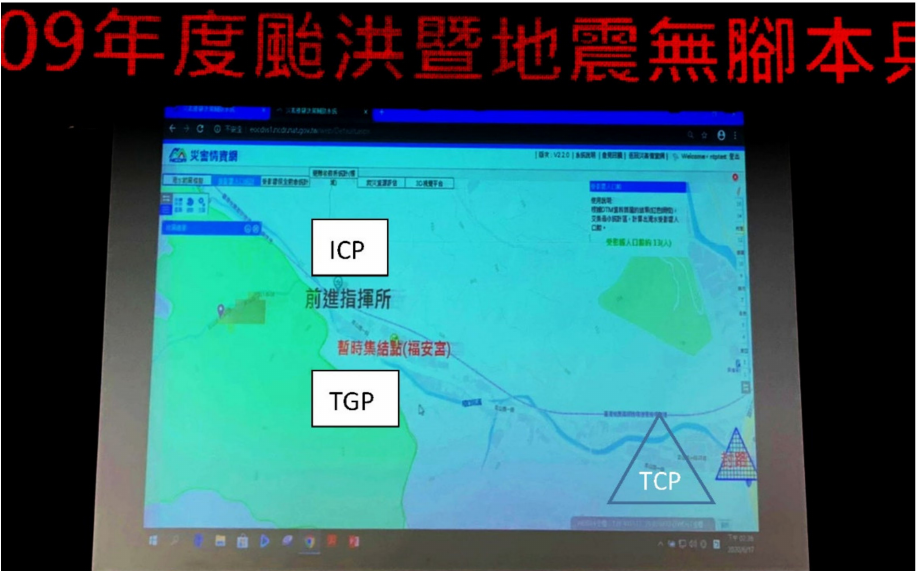
Figure 25. Easy-to-read labeling of the FWGAP. (Photographed by Yong-Jun